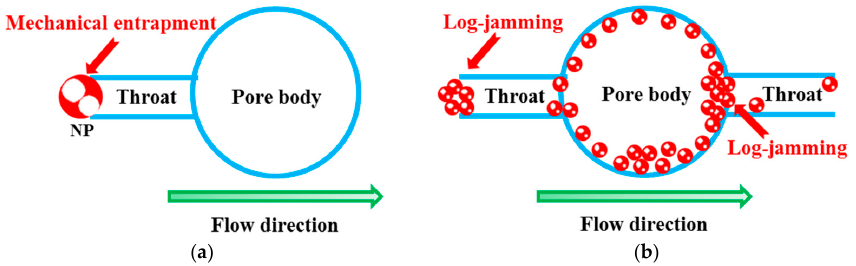
Figure 6. The schematic of two mechanisms causing pore channels plugging: ( a ) mechanical entrapment; ( b ) log-jamming.